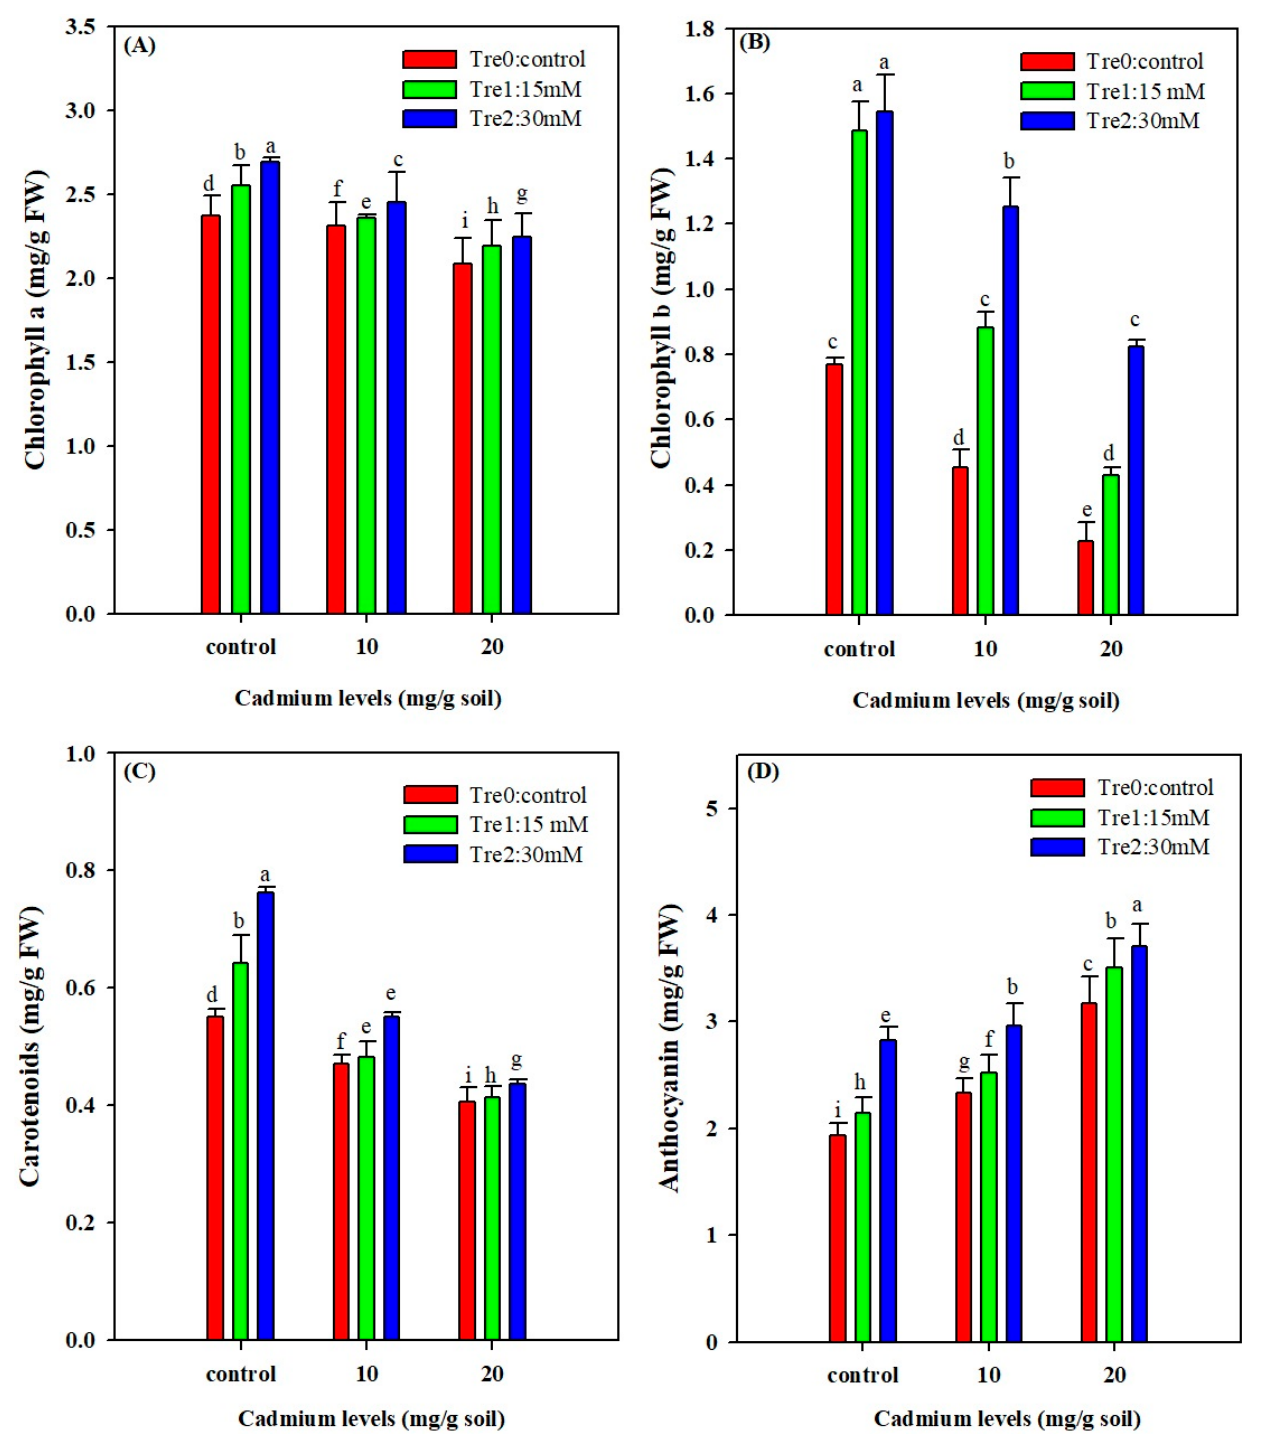
Figure 1. Effect of foliar application of Tre on chlorophyll a ( A ); chlorophyll b ( B ); carotenoid ( C ); and anthocyanin ( D ) contents of mung bean plants grown under Cd stress. The values given in vertical bars are showing the mean of three replicates with ± S.E and the different letters above the bars under the same treatment show the significant differences at p < 0.05.